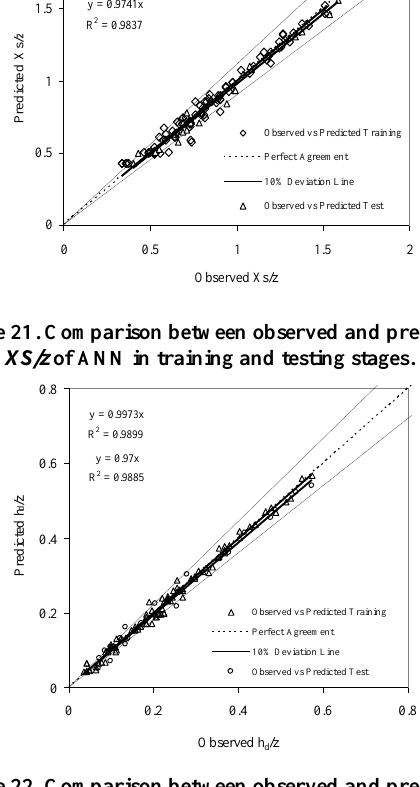
Figure 22. Comparison between observed and predicted h d /z of ANN in training and testing stages